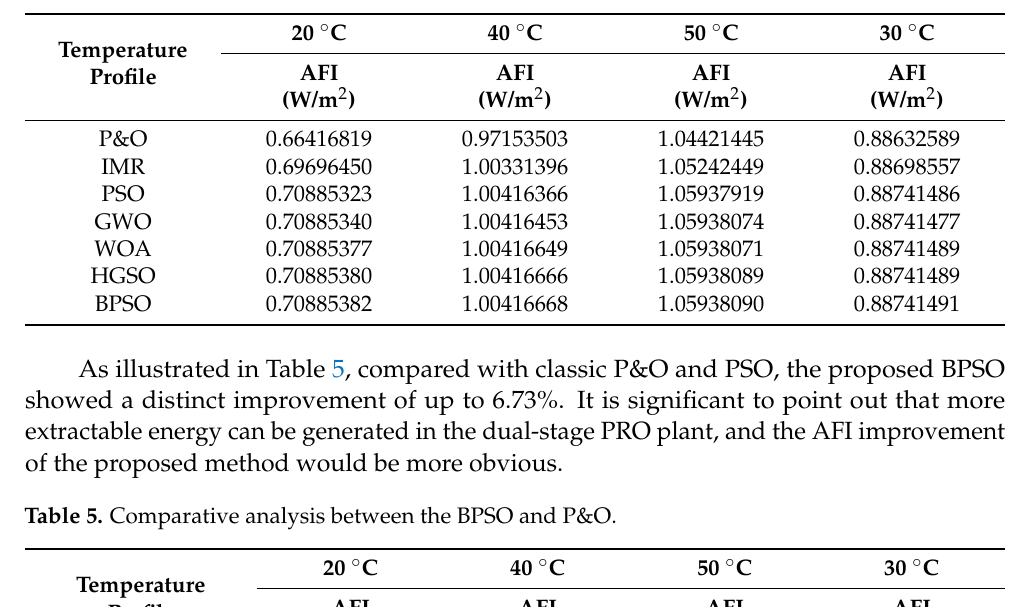
Table 4. Comparative analysis of the average power density extracted by different proposed MPPT algorithms under rapidly varying temperature profiles.